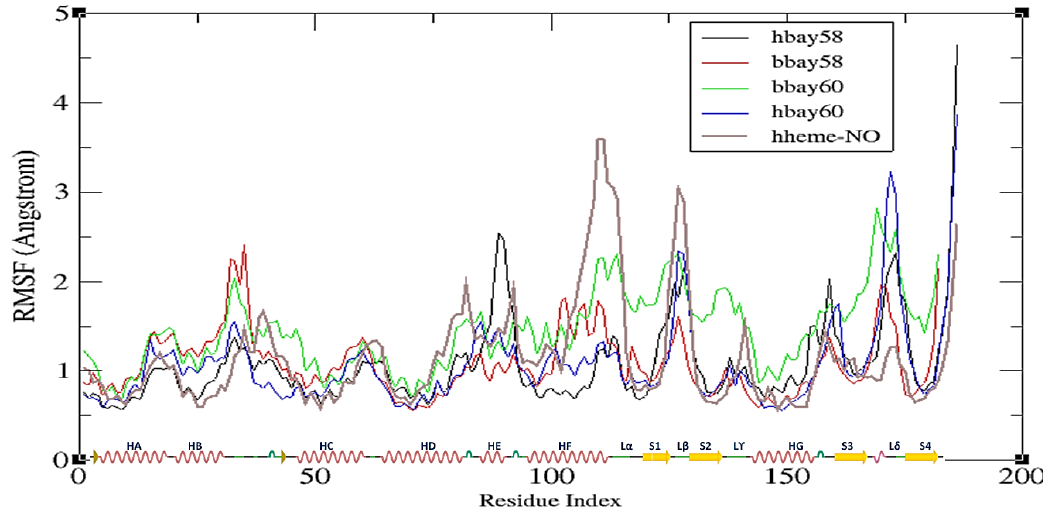
Figure 5. Average fluctuation experienced by each H-NOX residue, backbone atoms, represented as root mean square fluctuation or RMSF traces: hbay58 (black), bbay58 (red), bbay60 (green), hbay60 (blue) and NO bound heme Fe 2+ - h H-NOX or hheme-NO (purple) over the course of 50 ns simulation. Y-axis shows RMSF in Angstroms Å and X-axis represents H-NOX residues from N to C terminus (residue index). The X-axis also shows secondary structure layout of the H-NOX structure, helices are represented as red springs, loops as green lines, turns as green curves and strands as yellow arrows.